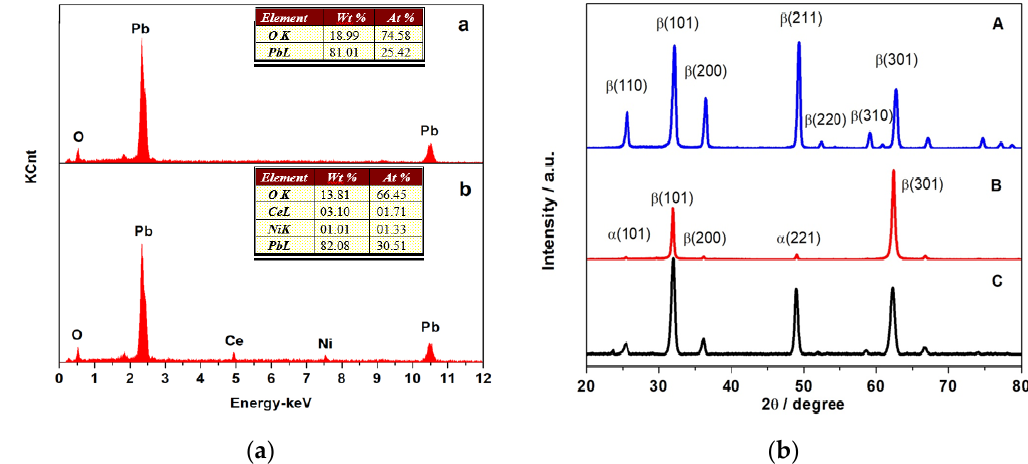
Figure 2. ( a ) EDS of a (porous PbO 2 electrode) and b (porous Ni-Ce-PbO 2 electrode); ( b ) XRD diffraction patterns of different Electrodes A (Porous Ti/Sb-SnO 2 /PbO 2 electrode), B (Porous Ti/Sb- SnO 2 /Ni-Ce-PbO 2 electrode), and C (Standard XRD pattern of PbO 2 ).